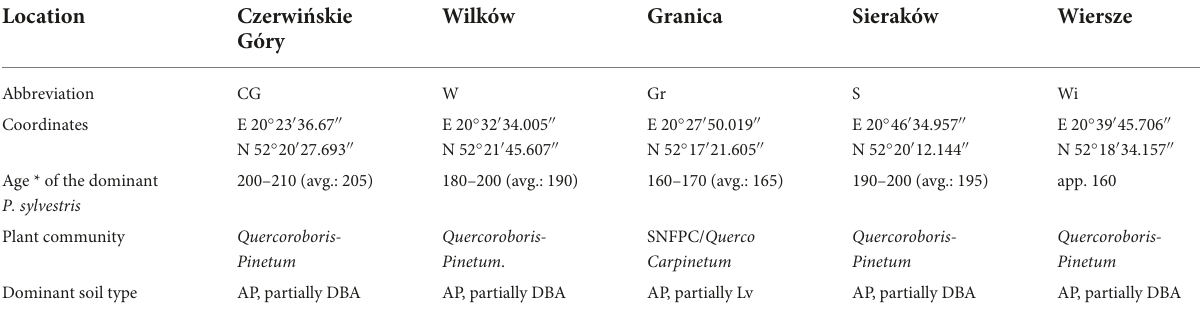
TABLE 1 The characteristics of the